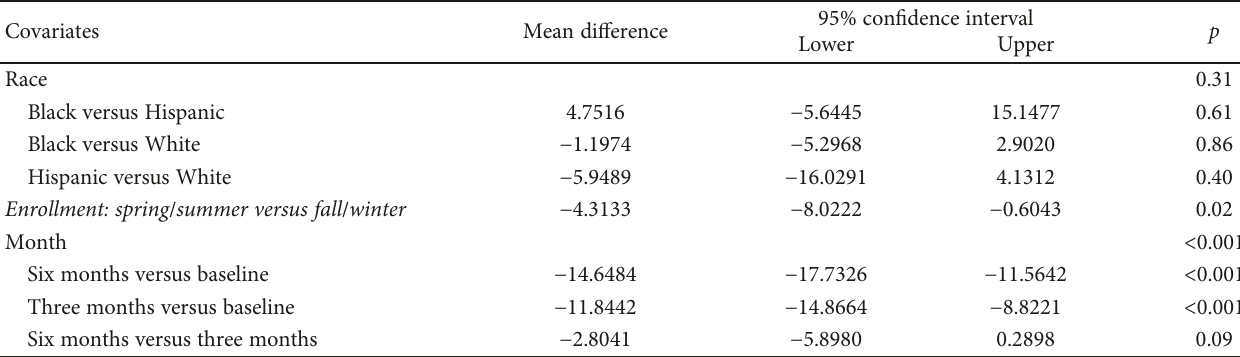
supplementation with 2